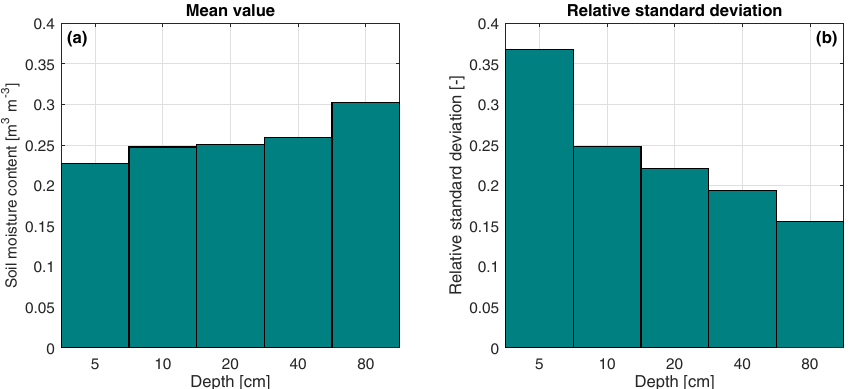
Figure 10. Soil moisture average and relative standard deviation (ratio of the standard deviation to the average soil moisture content), averaged over time (5 April 2016–4 April 2017) and over all stations for each depth